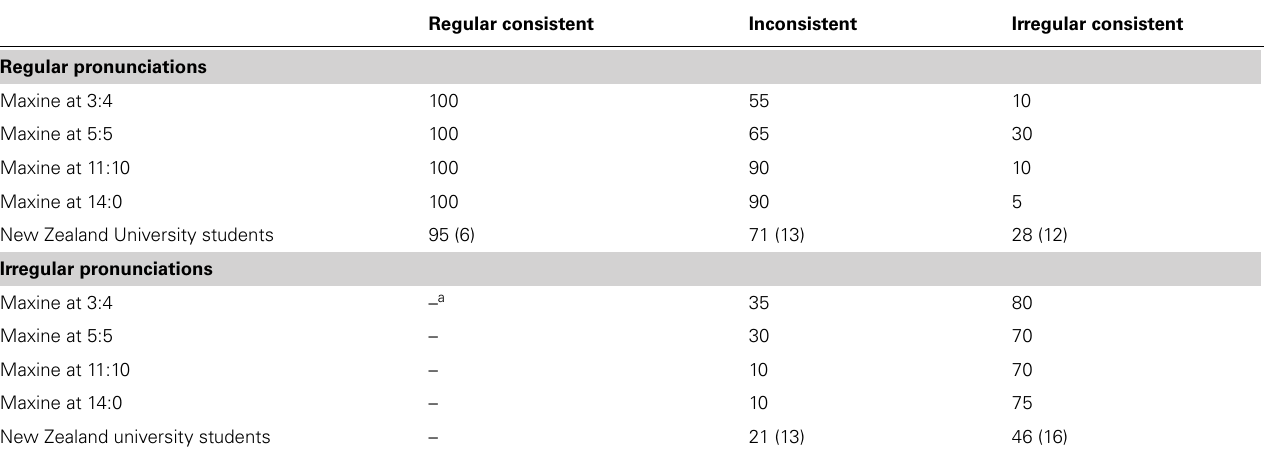
Table 4 | Experiment 2: Mean percentage of regular and irregular pronunciations for Coltheart and Leahy nonwords varying in regularity and consistency of body spelling for Maxine from 3:4 to 14:0, and New Zealand university students without phonics instruction (standard deviation in